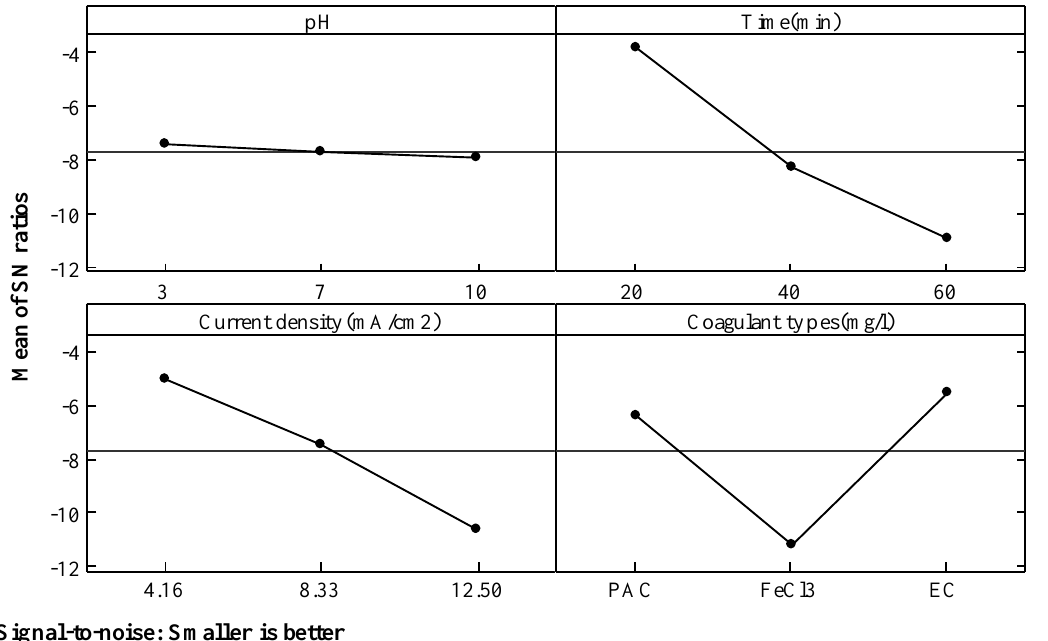
Fig. 2. Main effects plot of the independent parameters for the response of operating costs (US$/m 3 ) in Taguchi